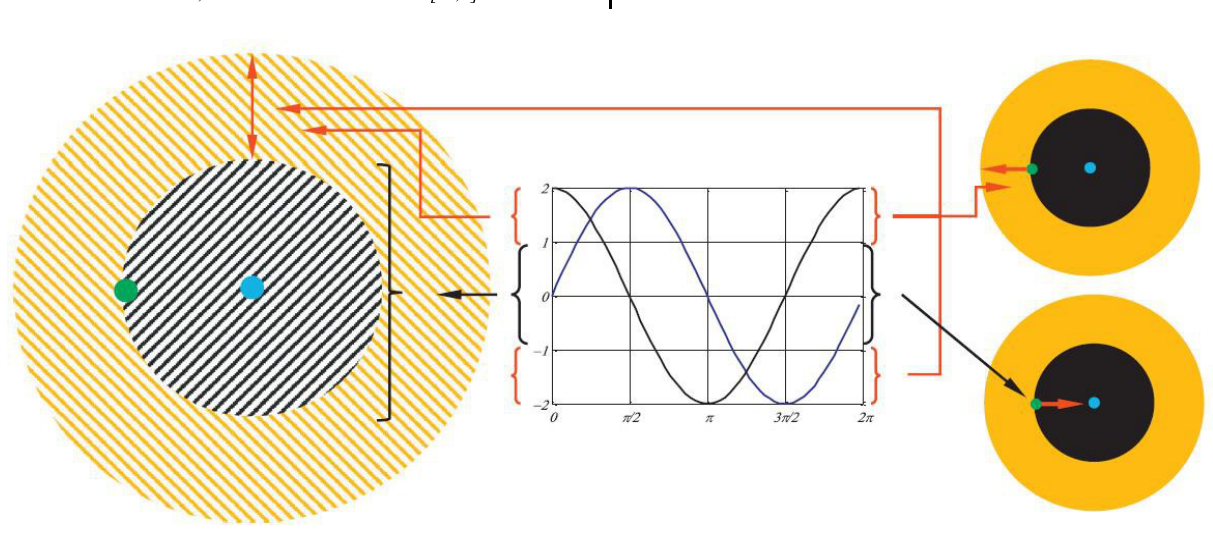
FIG. 3. SINE, COSINE IN THE RANGE IN [“2,2] REPRESENTING HOW A SOLUTION GOES INSIDE OR OUTSIDE THE SPACE